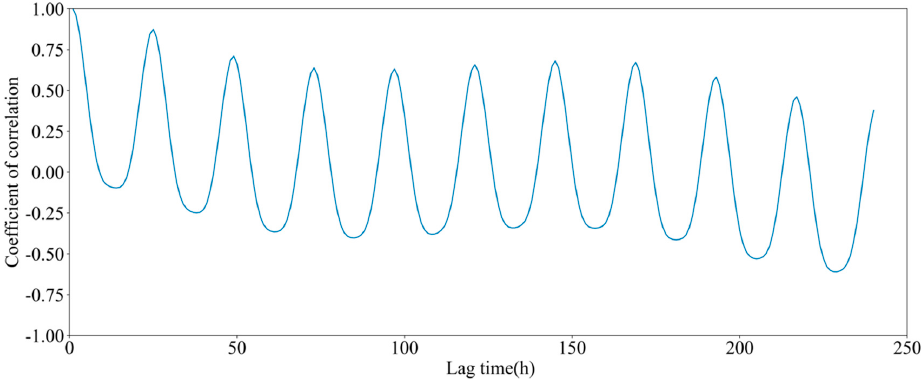
Figure 8. The autocorrelation of load data.